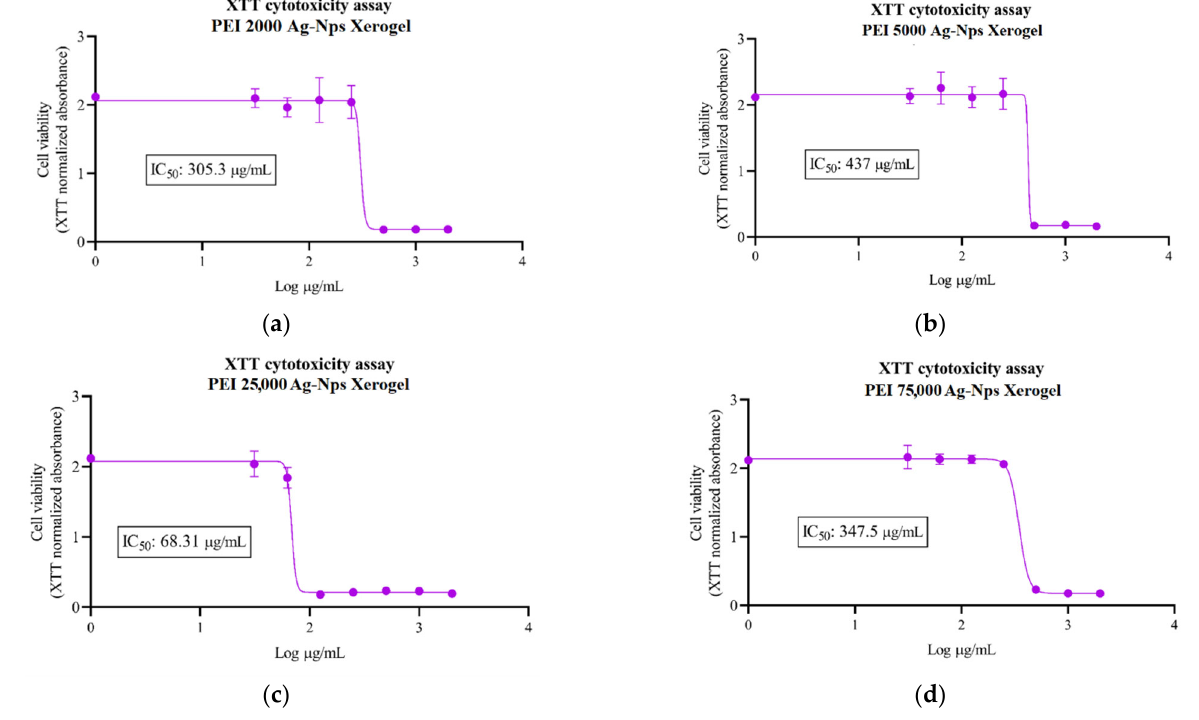
Figure 8. Cytotoxicity of the xerogels produced from hyperbranched PEI matrices of different Mw ( a ) 2000, ( b ) 5000, ( c ) 25,000, and ( d ) 750,000